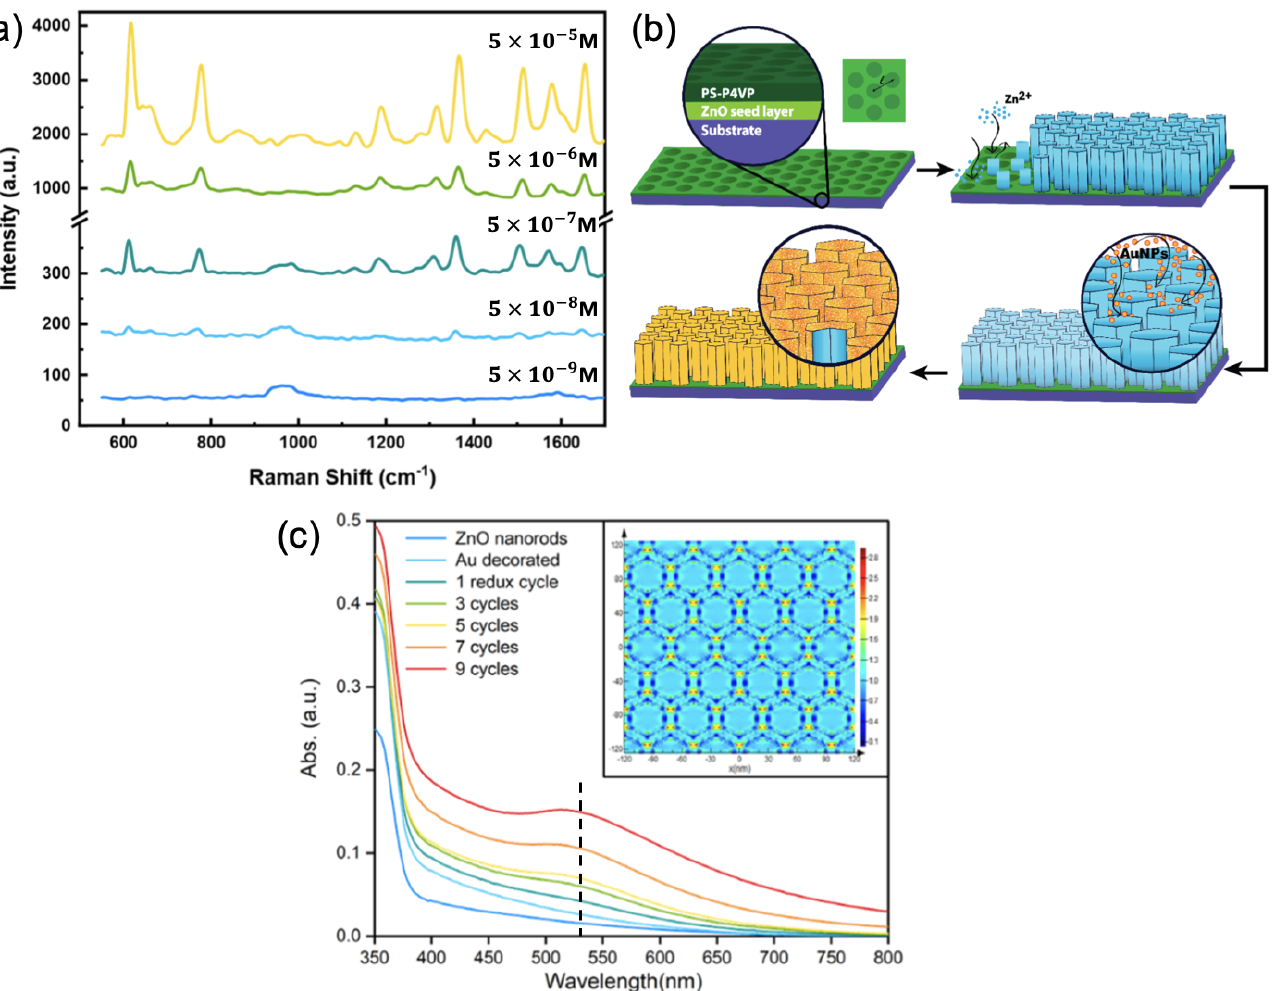
Figure 1. ( a ) SERS spectra of R6G molecules on the plasmonic metasurface for different R6G con- centrations; ( b ) illustration of the fabrication process of the plasmonic metasurface composed of gold-coated ZnO nanorods; and ( c ) absorbance spectra of the plasmonic metasurface at different reduction cycles. The black dashed line corresponds to the excitation wavelength for SERS measure- ments. Inset displays the electric field mapping in the Au/ZnO nanorod array. All the figures are reprinted (adapted) with permission from [65], Copyright 2021 American Chemical